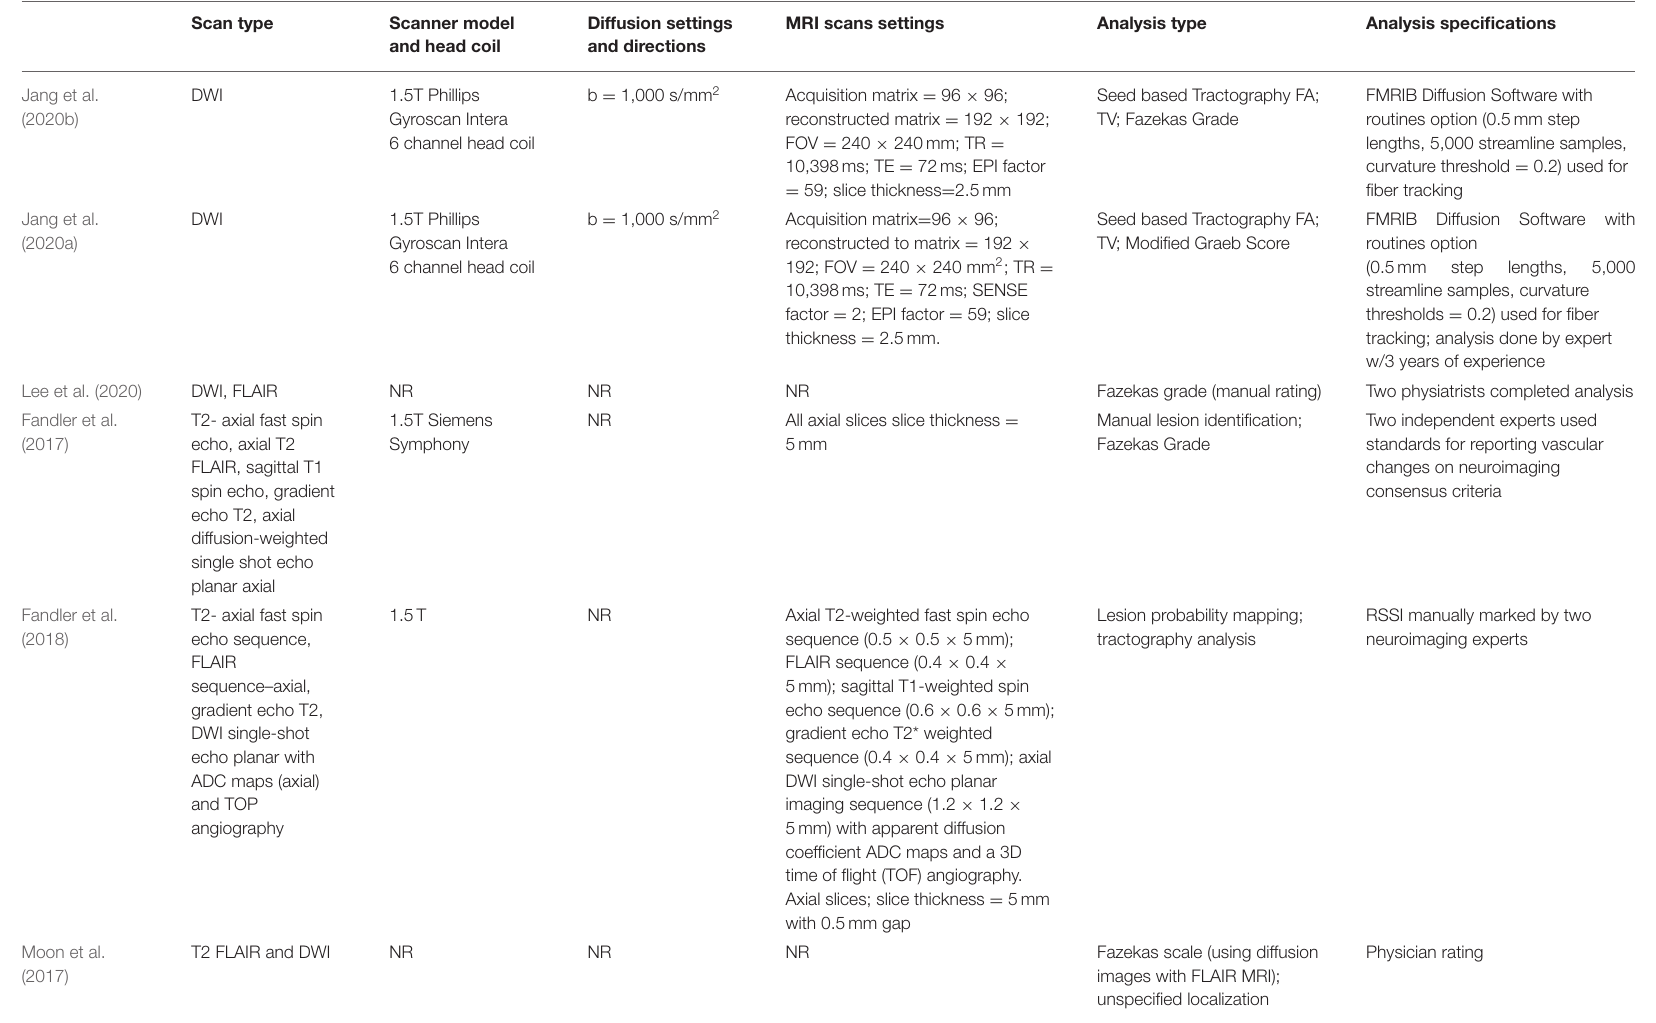
TABLE 3 | MR imaging specifications across